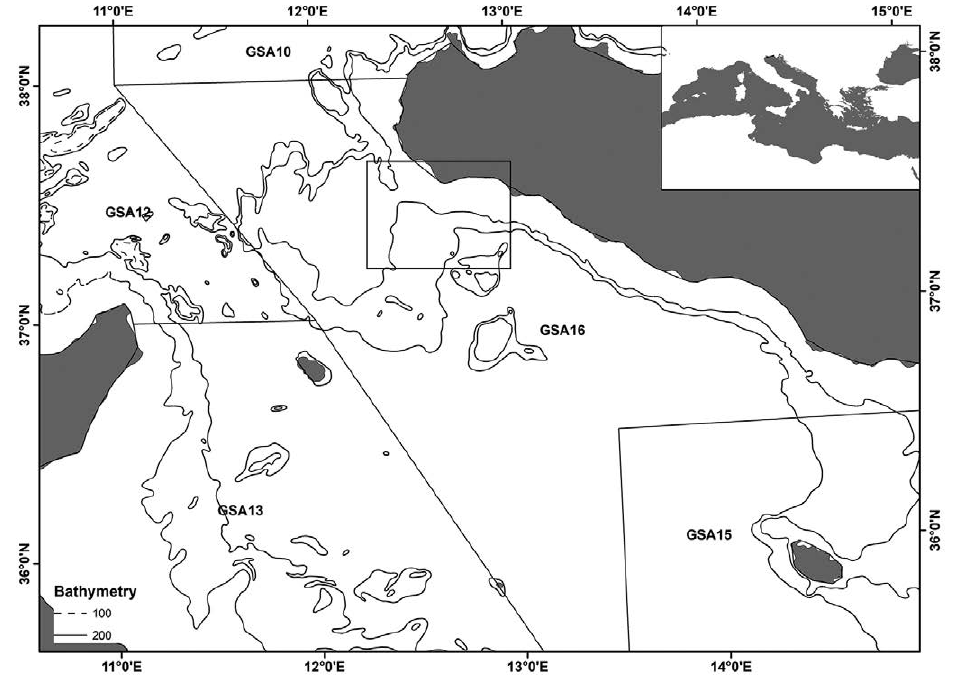
Fig. 1. – The study area highlighted with a black square